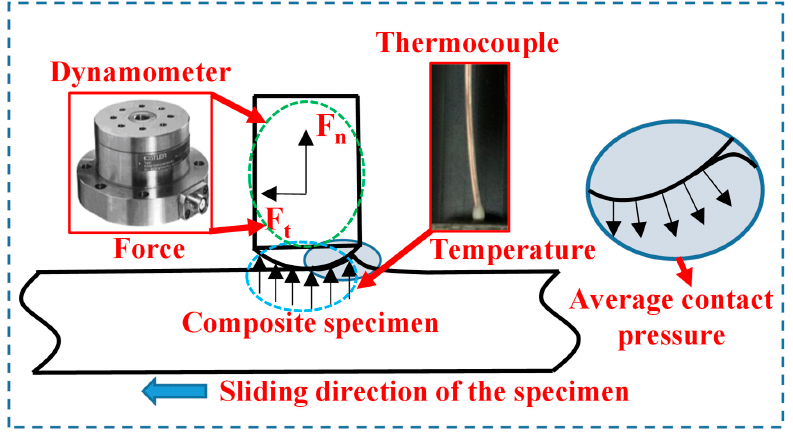
Figure 4. Photographs showing the two designed pins.